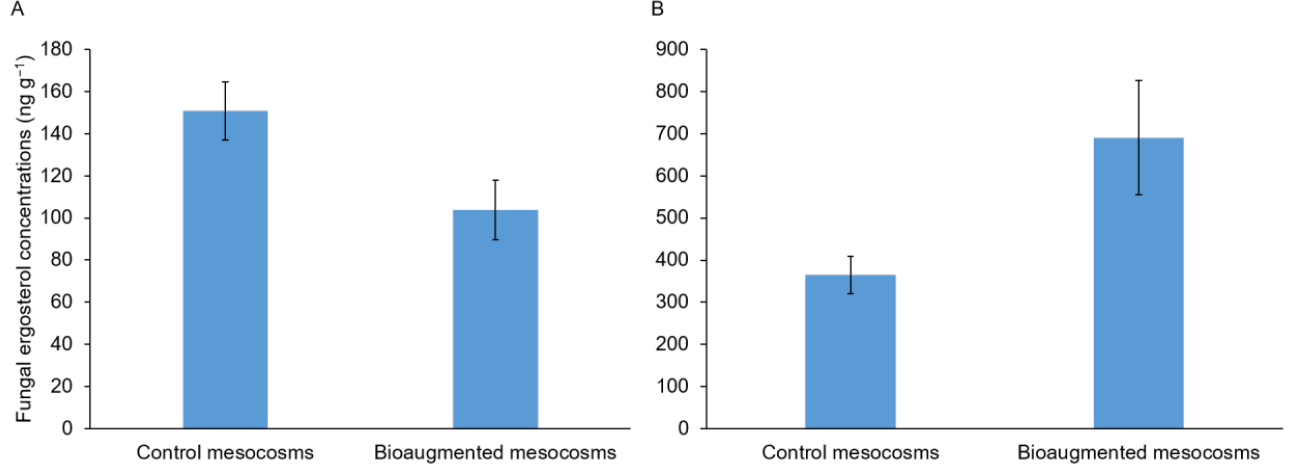
Figure 3. Fungal ergosterol concentrations (ng g − 1 soil) in the soil H ( A ) and in the soil L ( B ). Bars indicate mean ± standard deviation ( n = 3); (Student test; p -value = 0.1230 ( A ) and 0.1349 ( B )).